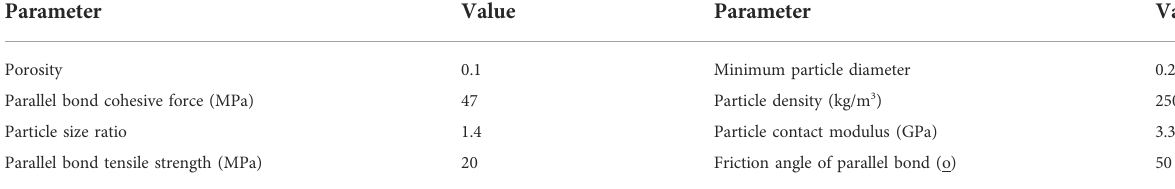
TABLE 1 Micro-parameters of the model in the numerical simulation. Parameter Value